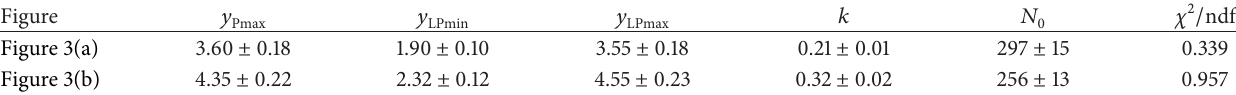
Table 2: Values of parameters and 𝜒 2 / ndf corresponding to the curves in Figures 2(a) and 2(b), where 𝑇 and 𝑞 are taken from Table 1 for the central cylinders at 𝑦 = 0 and for the leading nucleons at 𝑦 = 3.0 (or 2.9). See [14] on the discussions for the number of free parameters and the ndf.